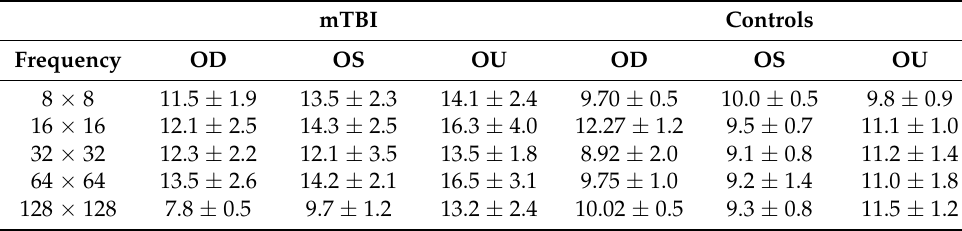
Table 3. VEP mean and standard error values, mTBI values and